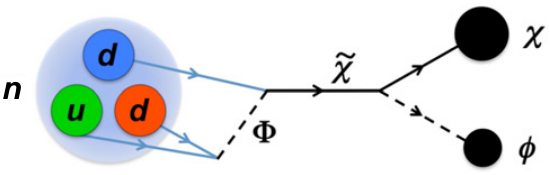
Figure 1. Neutron dark decay n → χ γ in Model 1.